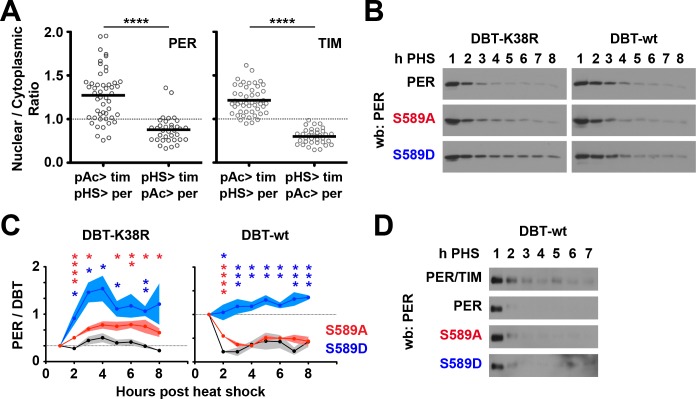
PER/TIM nuclear accumulation in S2 cells is promoter-dependent, PER stability is plotted as a PER/DBT ratio.(A) S2 cells were transfected with plasmids that express per-mCherry (PER) or tim-YFP (TIM) fusion genes by actin promoter (pAc>) or heat shock promoter (pHS>) as indicated. Cells were imaged 2 hr post heat shock and fluorescence signal in the nucleus and cytoplasm quantified, and the nuclear/cytoplasmic ratios plotted as shown. The black bar represents the mean. The dotted line represents the value at which nuclear and cytoplasmic signals are equal. ****p<0.001. Significance was measured by t-test. (B) Representative blot of mutant DBT (DBT-K38R) or wild type DBT (DBT-wt) co-expressed with TIM and the indicated PER variant, as described in Figure 3. (C) Quantified PER levels are quantified and plotted as a PER/DBT ratio. Left and right panels represent PER co-expressed with DBT-K38R and DBT-wt, respectively. Mutant PER (S589A, red line; S589D, blue line) are compared to wild type PER (black line). N = 4. Each data point represents the mean, ±SEM. Thickness of the curve reflects SEM. Asterisks represent significance of difference between the indicated mutant (S589A, red; S589D, blue) and wild type. *p<0.05. **p<0.01. ***p<0.005. ****p<0.001. Significance was measured by t-test. (D) Representative blots of PER expression in S2 cells with wild type DBT and no TIM. Blots were overexposed to ensure observable protein signal in the first hour.